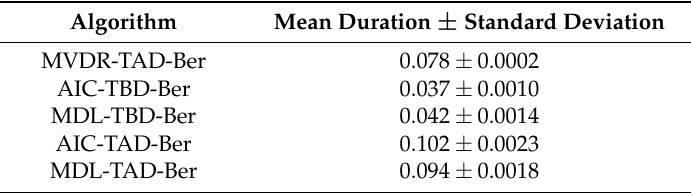
Figure 8. OPSA error averaged over time steps (100 Monte Carlo runs) versus SNR. Vertical panels (top to bottom) vary in number of snapshots N = 50, 100, 200. Table 1. Computation time of different algorithms per